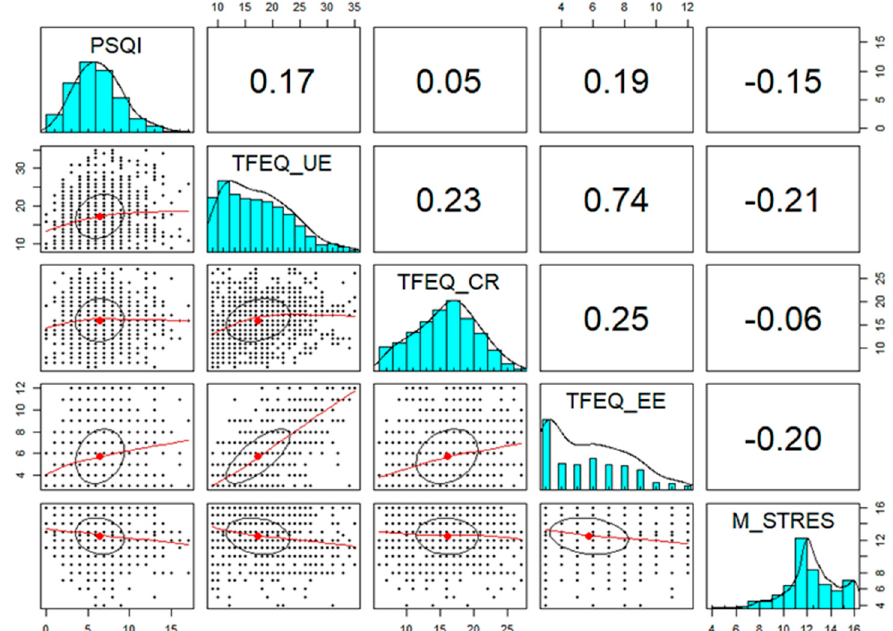
Figure 2. Correlation matrix: sleep quality, stress management, and eating. Note. PSQI = Sleep quality; TEFQ_UE = Uncontrolled eating; TFEQ_EE = Emotional eating; TFEQ_CR = Cognitive restriction; M_Stress = Stress management.